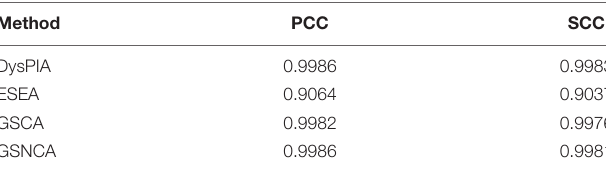
TABLE 3 | The correlation coefficients of P -value between 1,000 and 10,000 permutations.